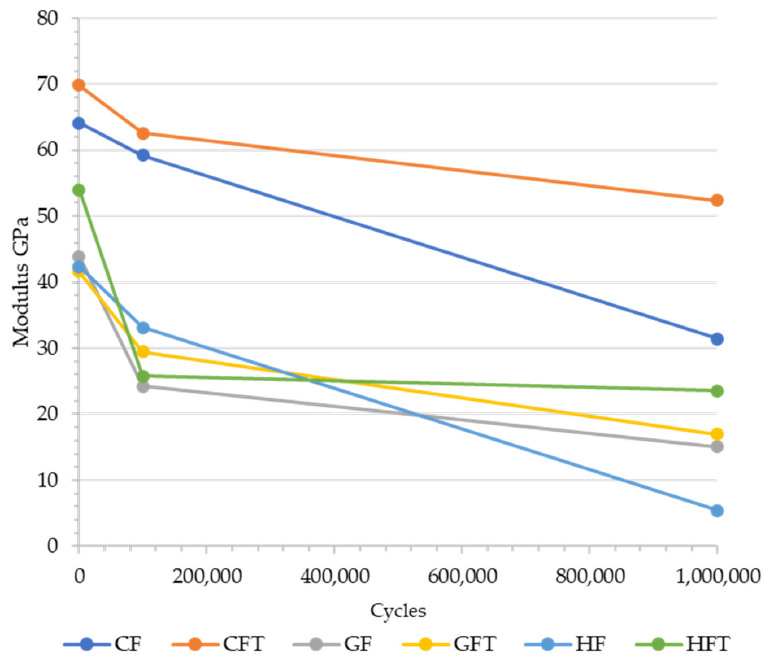
Figure 22 . Number of cycles, compared with the modulus of CFRP, GFRP, and HFRP and their veil toughened counterparts . toughened